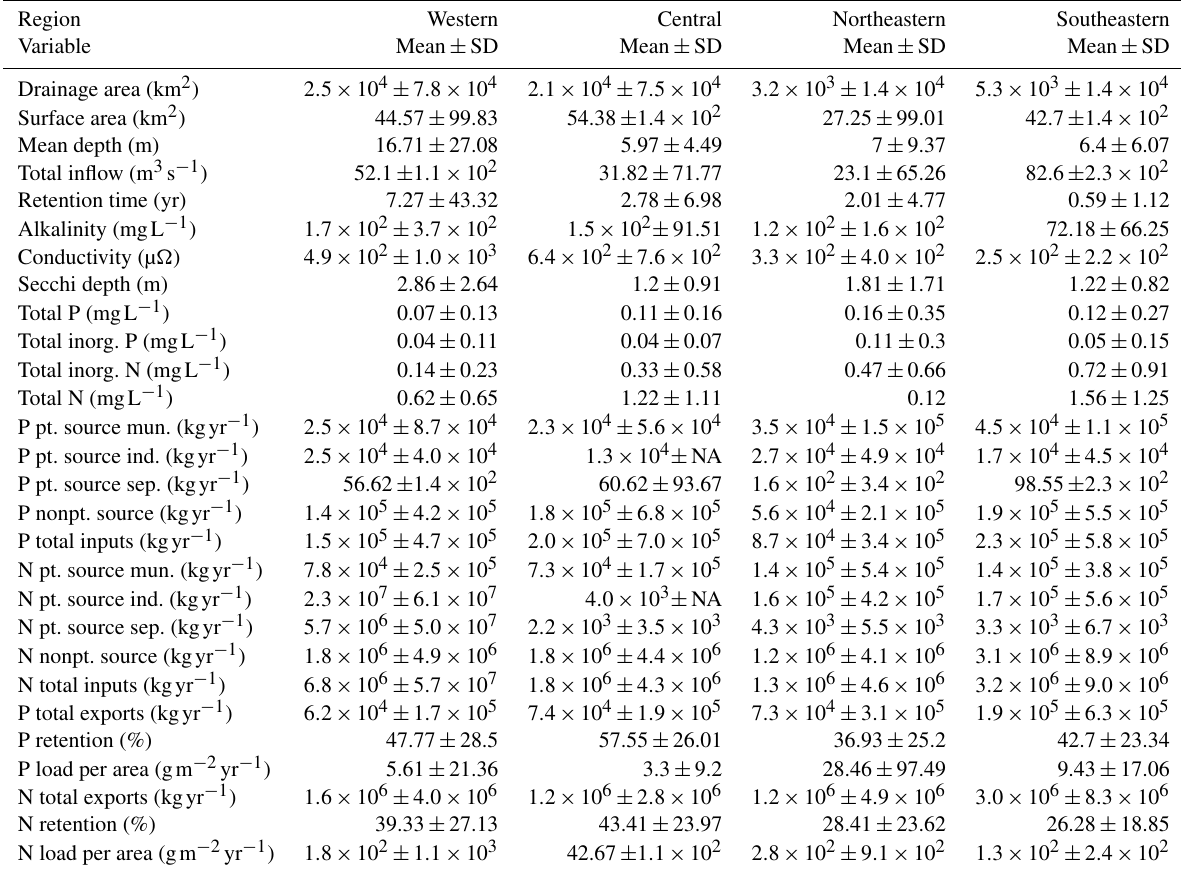
Table 2. Mean and standard deviation (SD) for each variable in each NES region. Region Western Central